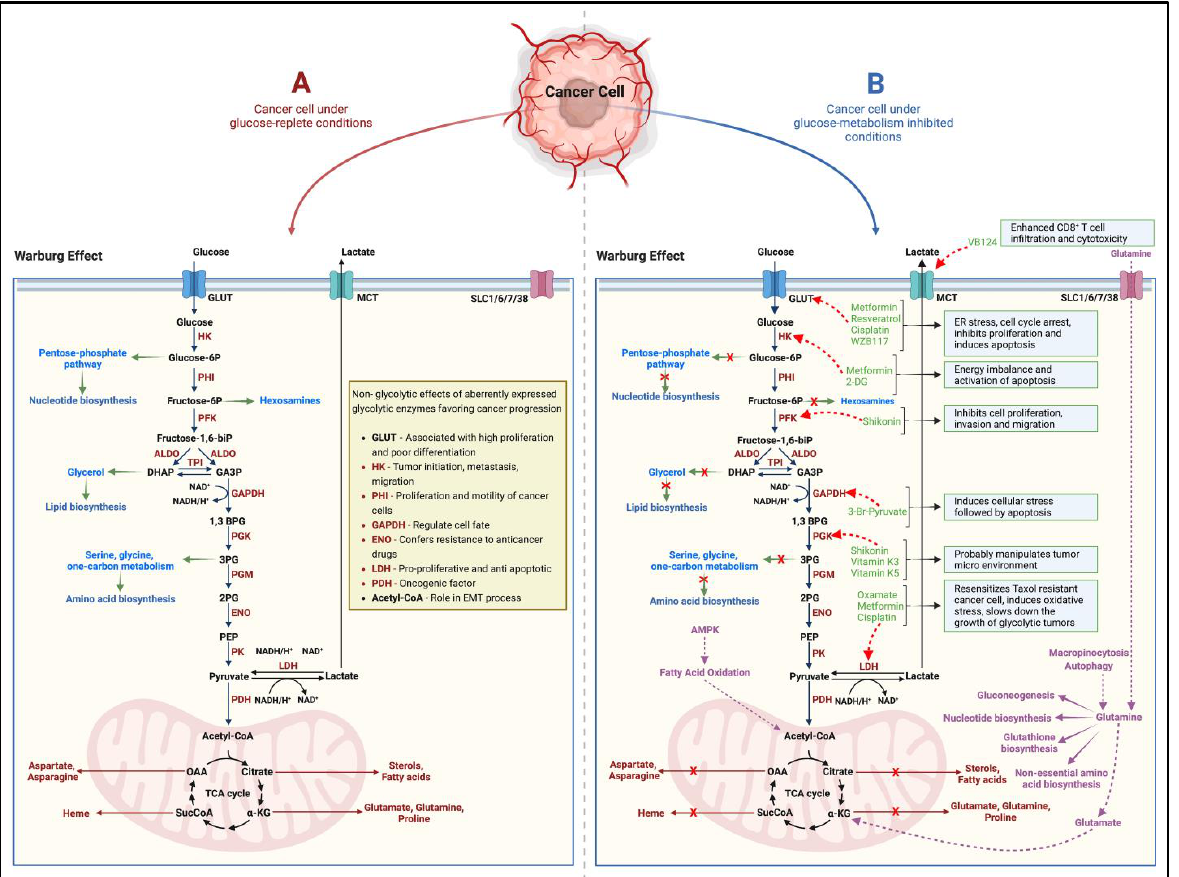
Figure 1. Schematic ( A ) indicates the altered glucose metabolism (Warburg effect) under the effect of glucose in cancer cells. While several of the glycolytic intermediates replenish precursor molecules for macromolecular biosynthesis in the rapidly growing tumor, alterations in the expression and function of metabolic enzymes have been shown favor cancer progression in several ways. Several pharmacological agents, naturally occurring compounds, and small-molecule inhibitors ( B ) effectively block the tumorigenic ability of the target enzymes and metabolic pathways. However, the cancer cell can adapt to utilize glutamine metabolism as an alternate pathway to derive cellular energy and maintain the supply of precursors for macromolecular biosynthesis. The black and brown arrows indicate the pathway and flow of components involved in the pathway. The green arrows indicate how glycolytic intermediates can act as precursor molecules for the biosynthesis of various macromolecules. The red ‘x’ marks indicate how inhibiting glucose metabolism in cancer cells shuts off the supply of precursor molecules for macromolecular biosynthesis. The red dotted arrows indicate the inhibitory nature of the pharmacological agents, naturally occurring compounds, and small-molecule inhibitors on the target enzymes/proteins. The purple arrows alternate/adaptive metabolic pathways that support growth and proliferation of cancer cells. HK = Hexokinase, PHI = Phospho-hexose isomerase, PFK = Phosphofructokinase, ALDO = Aldolase, TPI = Triose-phosphate isomerase, GAPDH = Glyceraldehyde phosphate dehydrogenase, PGK = Phosphoglycerate kinase, PGM = Phosphoglycerate mutase, ENO = Enolase, PK = Pyruvate kinase, LDH = Lactate dehydrogenase, PDH = Pyruvate dehydrogenase, GLUT = Glucose transporter, MCT = Monocarboxylate transporter, SLC = Solute carrier transporter. Created with